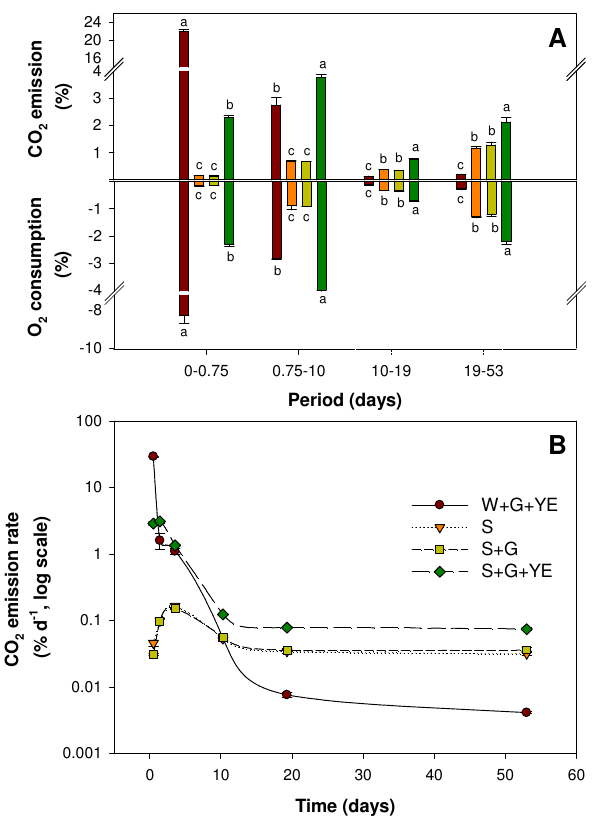
Figure 3 Fig. 3. (A) Total (labelled + unlabelled) CO 2 emission and O 2 consumption from irradiated-soil ( S ); irradiated-soil + labelled glucose ( S + G ); irradiated-soil + labelled glucose + yeast- extract ( S + G + YE); water + labelled glucose + yeast-extract ( W + G + YE) for four periods of incubation. Results are ex- pressed as % of microcosm atmosphere. Water with labelled glucose was also incubated as control, but CO 2 emission from this control was null and not reported. Letters at each sampling date indicate the ANOVA-based differences at 5% P-level among treatments. (B) Total (labelled + unlabelled) CO 2 emission rate from water and soil microcosms. Symbols are the same as Fig. 3a.